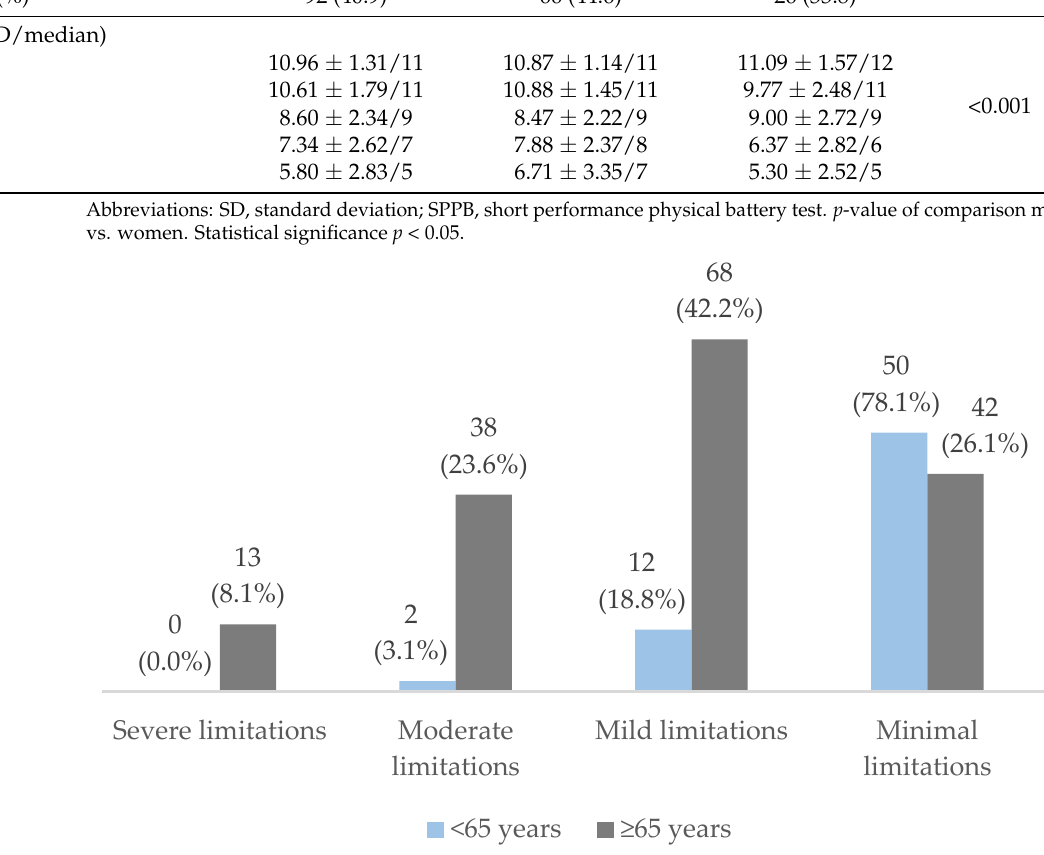
Abbreviations: SD, standard deviation; SPPB, short performance physical battery test. p -value of comparison men vs. women. Statistical significance p < 0.05.